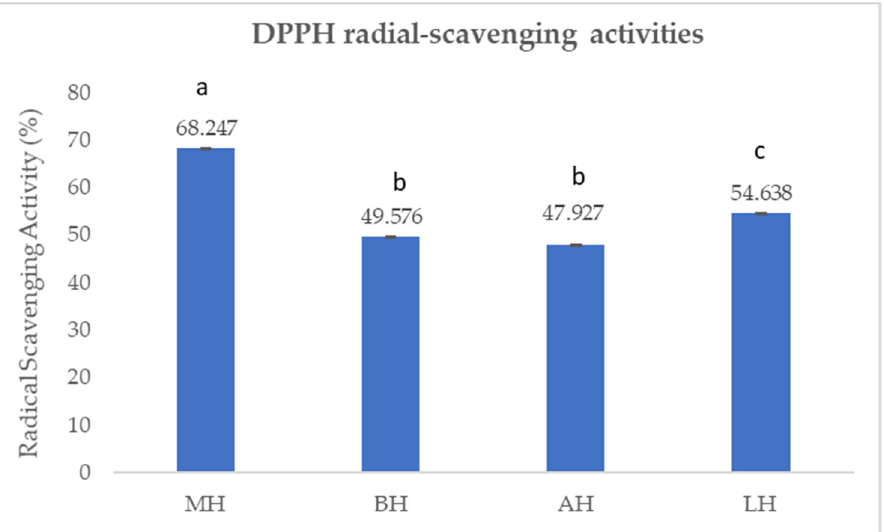
Figure 3. DPPH radical scavenging of the honey samples. Mean values expressed as %. The error bars indicate the standard deviation. Different letters among samples indicate significant differences ( p < 0.05) among values according to the t-test.